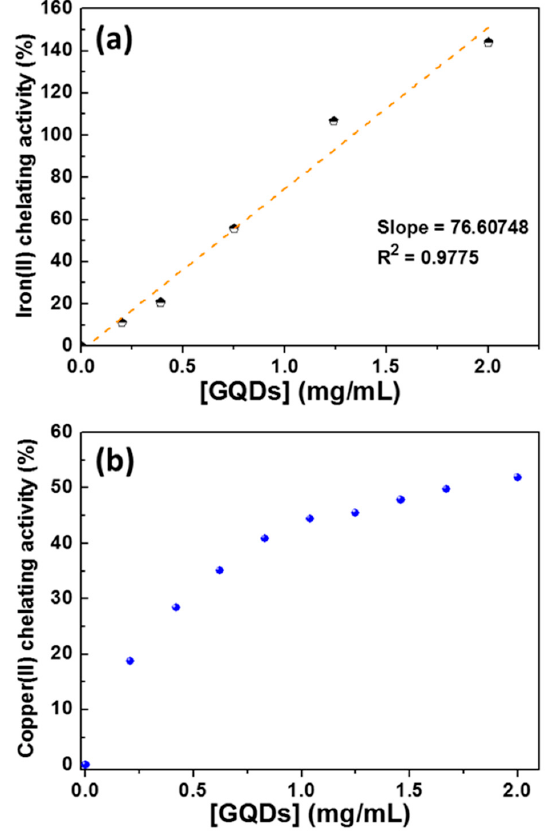
Figure 8. ( a ) Fe(II) and ( b ) Cu(II)-chelating abilities of GQDs.